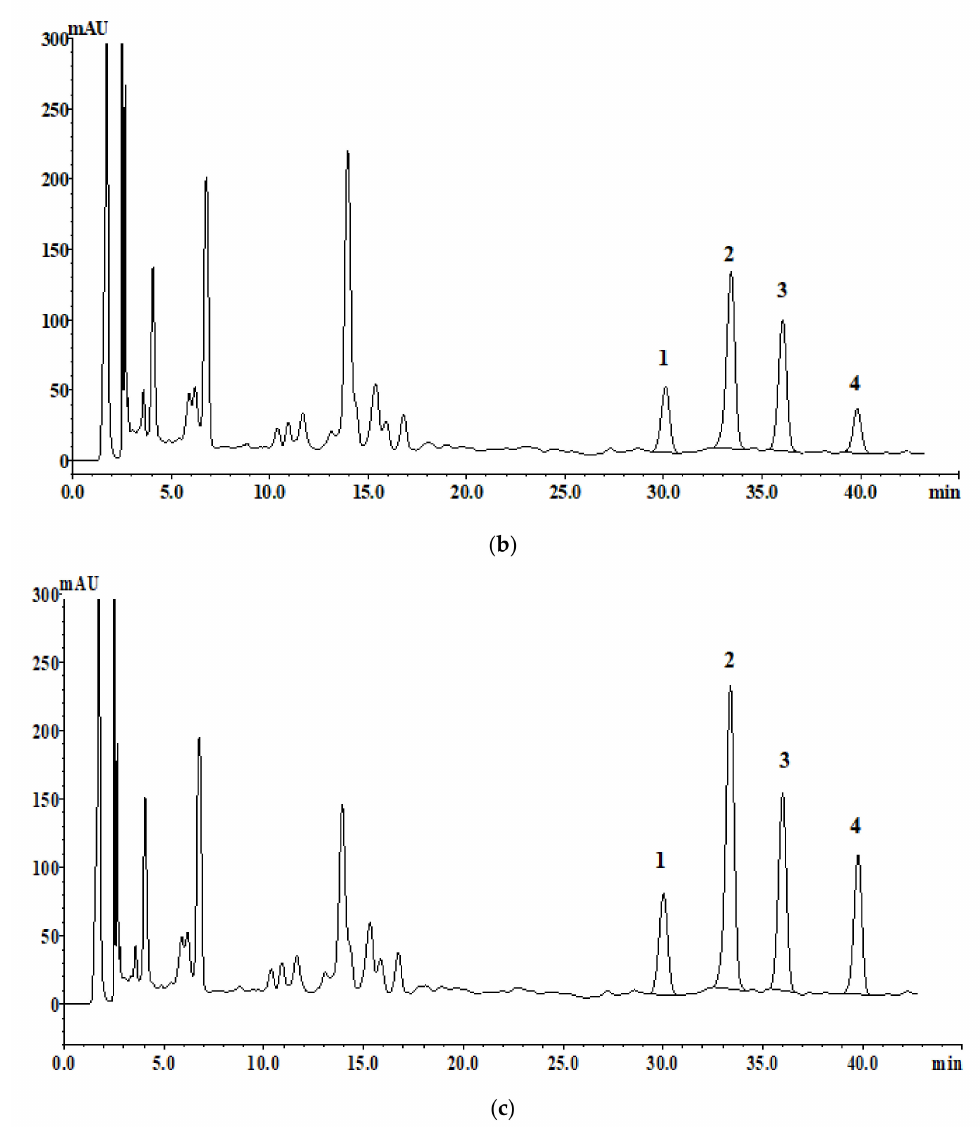
Figure 1. HPLC chromatograms analysis of the four standards: ( a ) (0.35 mg/mL), ( b ) aqueous extraction (100 mg/mL), and ( c ) 30% ethanolic extraction (100 mg/mL). Table 1. Contents of the four compounds in the aqueous and 30% ethanolic extracts of A. fistulosum . Aqueous Extractions Compounds